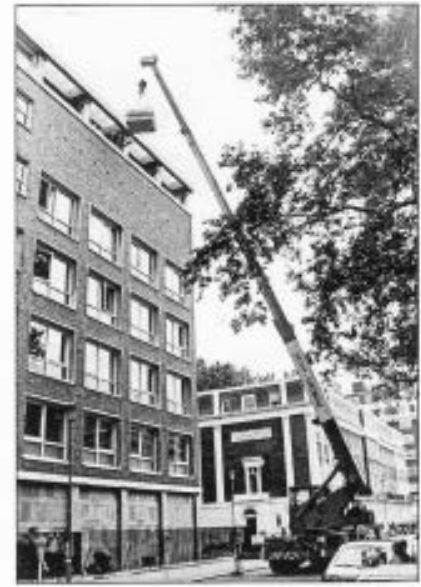
Figure 4 Modern reconstruction of an organic reed and twine core based on impressions left in the interiors of two of the large statues, Reema and